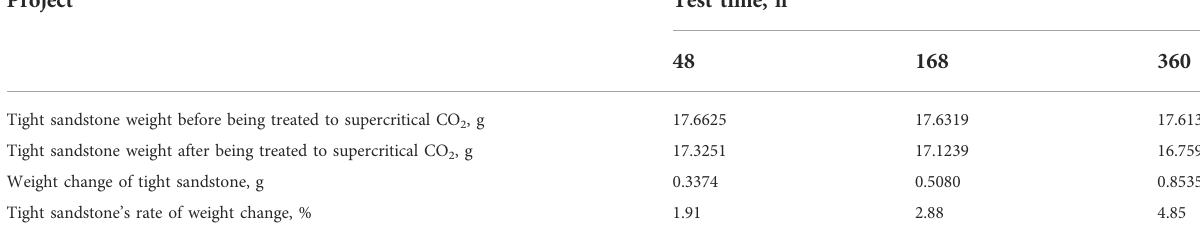
TABLE 1 Tight sandstone weight variation after supercritical CO 2 at various